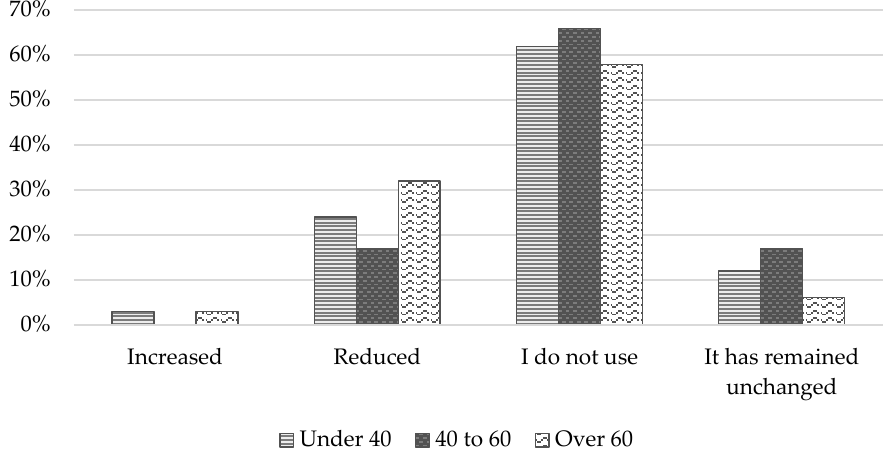
Figure 17. Public transport use in the RMSC after COVID-19.